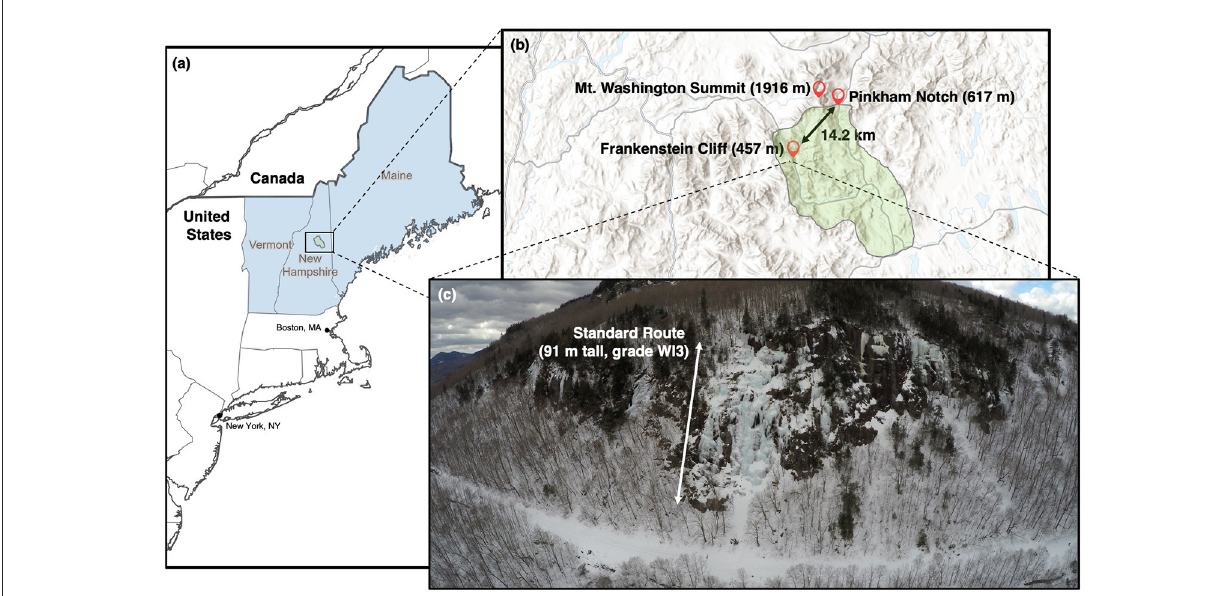
FIGURE1 The geographic context of Standard Route within the United States. (a) Northern New England consists of the states Maine, New Hampshire, and Vermont, which border Canada. The approximate outline of the upper Mount Washington Valley is shaded. (b) The Mount Washington Valley hosts the highest mountains in the Eastern United States. Mt. Washington, Pinkham Notch, and Frankenstein cliff are all within 15km of each other. (c) An aerial view of the ice climb Standard Route, the largest climb at Frankenstein cliff (photo by Ross Henry). The climb is rated WI3, which indicates a sustained 70 ◦ angle, with short bulges and curtains approaching 90 ◦